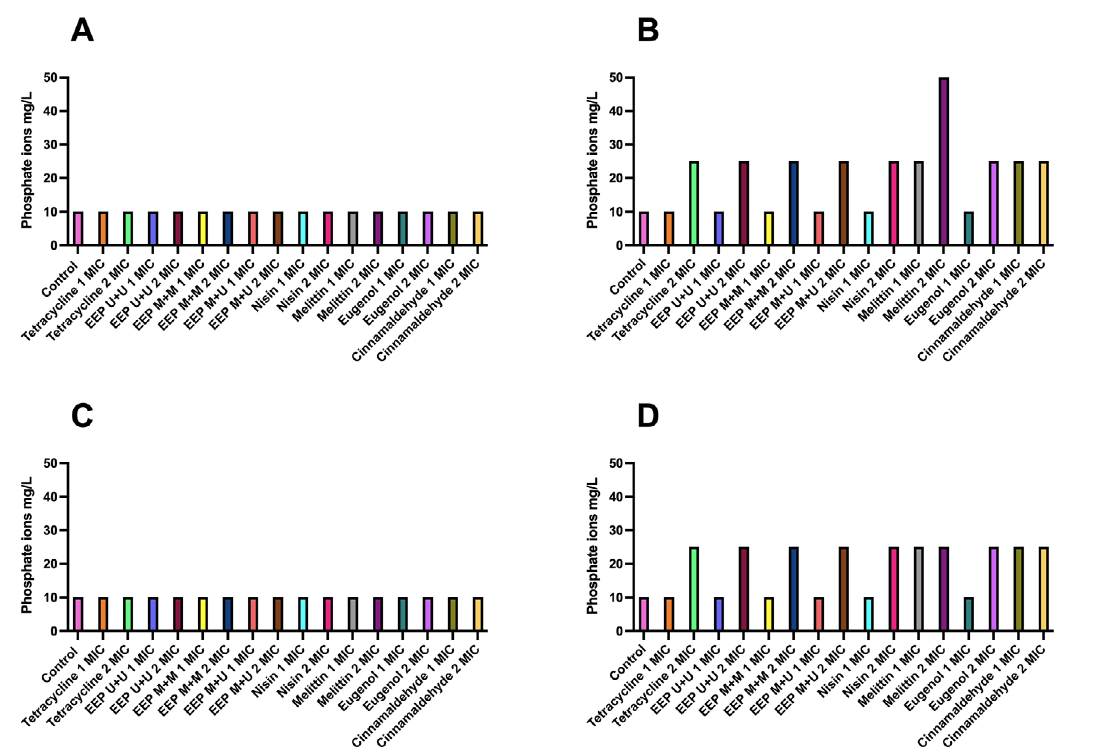
Figure 4. Release of phosphate ions from B. subtilis at times (A) T0 and (B) T4 and P. alvei at times (C) T0 and (D) T4 after treatment with tested products at concentrations of 1 and 2 MIC.